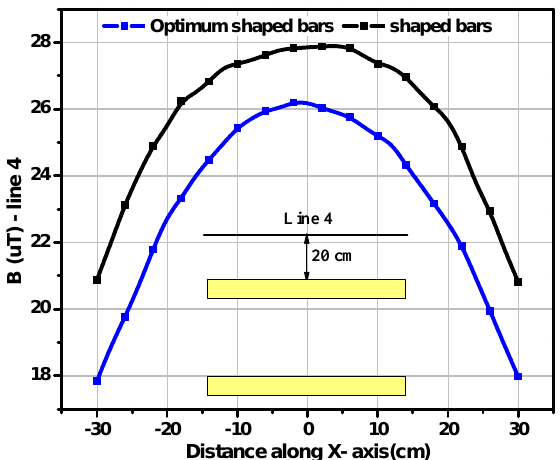
Figure 16. B r ms along a line located horizontally, 20 cm from the Rx aluminium sheet for shaped bars and optimum shaped